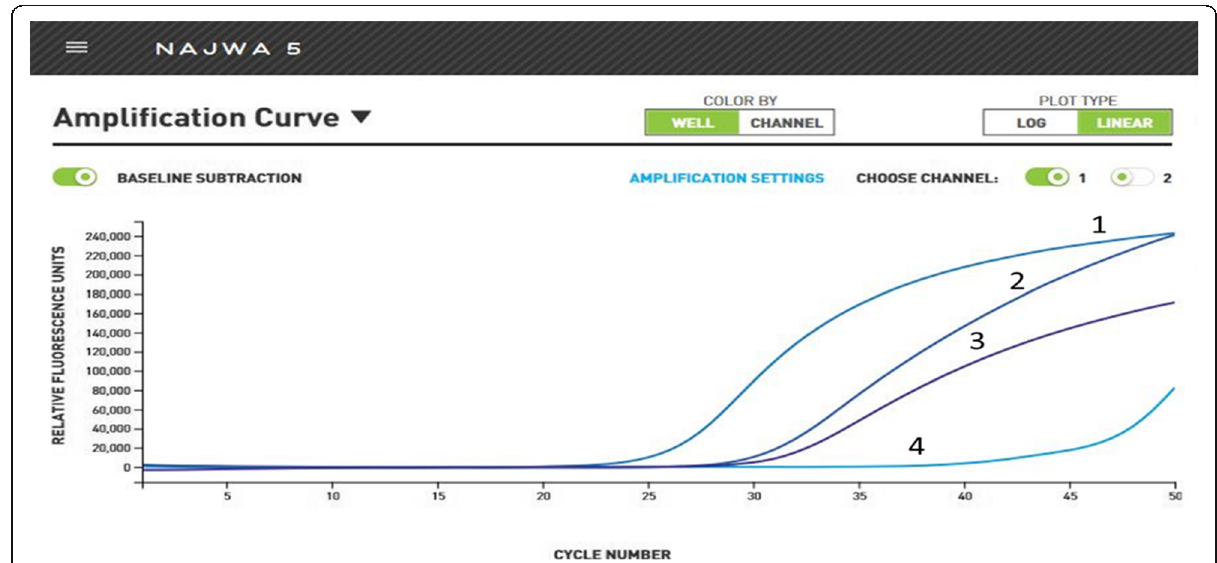
Fig. 2 The fluorescent Ct curve for KT (1 = M28, 2 = M1, 3 = M2 and 4 = ACT) genes for Wickerhamomyces